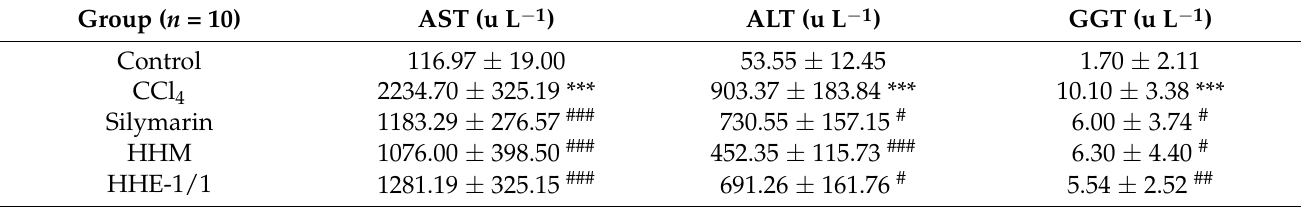
Table 2. HHM and HHE-1/1 effect on liver enzymes activity of CCl 4 -induced liver fibrosis.